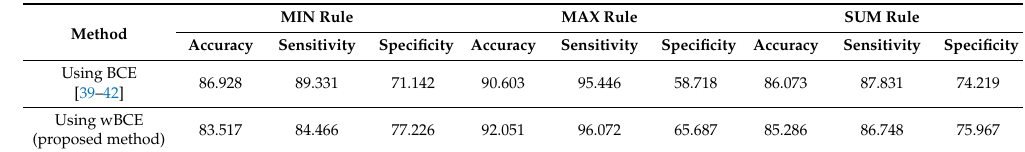
Table 8. Classification performance of our proposed method using the TDID dataset with MIN, MAX, and SUM rules (unit: